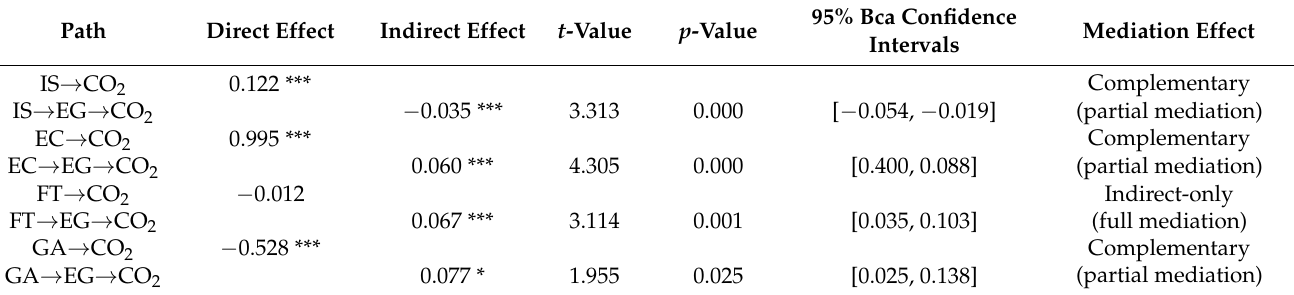
Table 4. Results of direct, indirect, and mediating effects of economic growth.